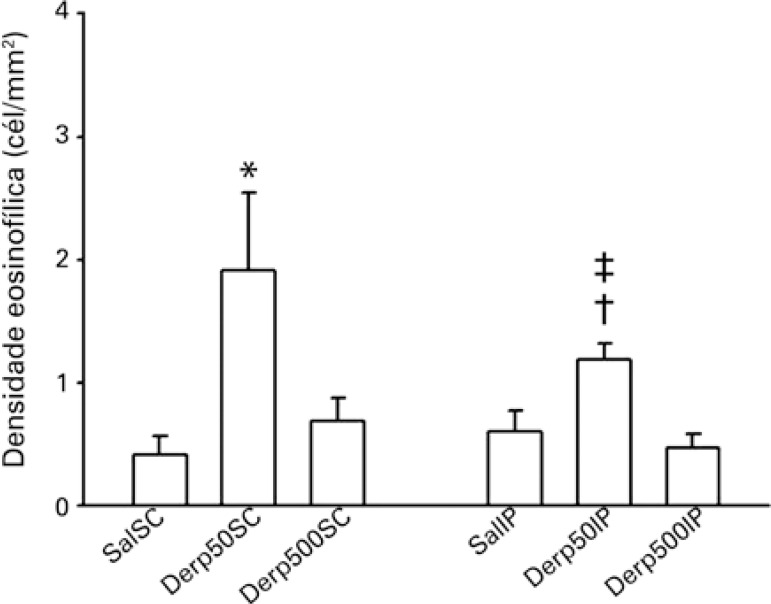
Valores de média ± erro padrão da densidade eosinofílica no espaço peribroncovascular (hematoxilina e eosina). A densidade foi determinada pela contagem do número de eosinófilos presentes no infiltrado inflamatório, entre o brônquio e a artéria adjacente, dividido pelo número de pontos correspondendo à área total do infiltrado inflamatório, num aumento de 1000x